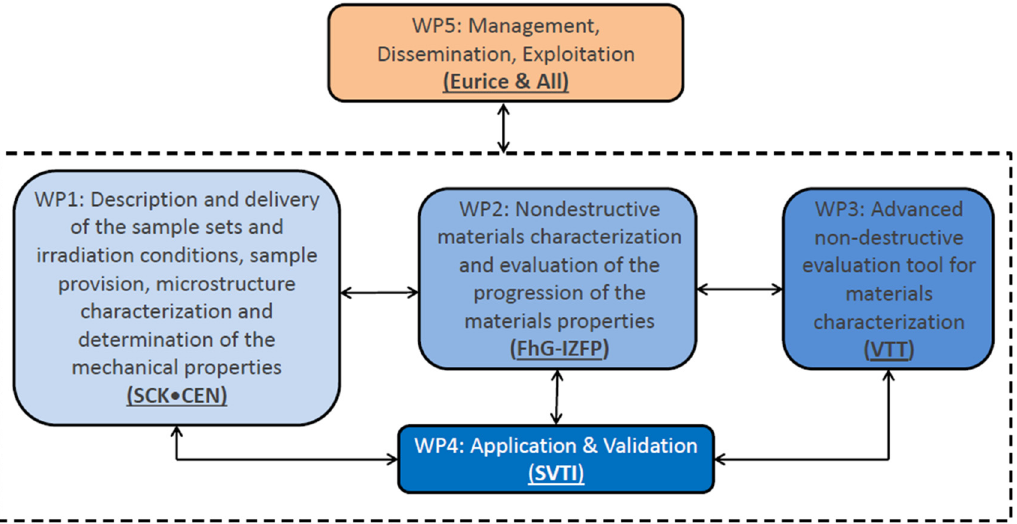
Fig. 2. NOMAD work